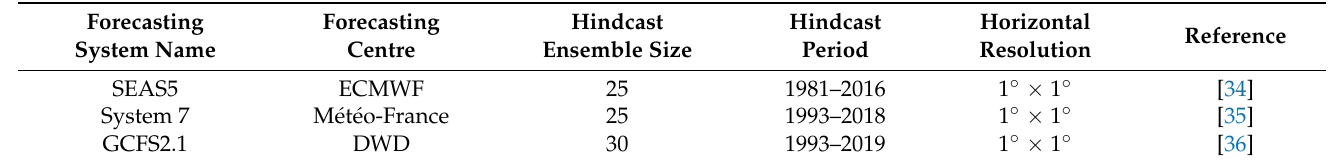
Table 1. The three forecasting systems in the Copernicus Climate Change Service (C3S) and their original